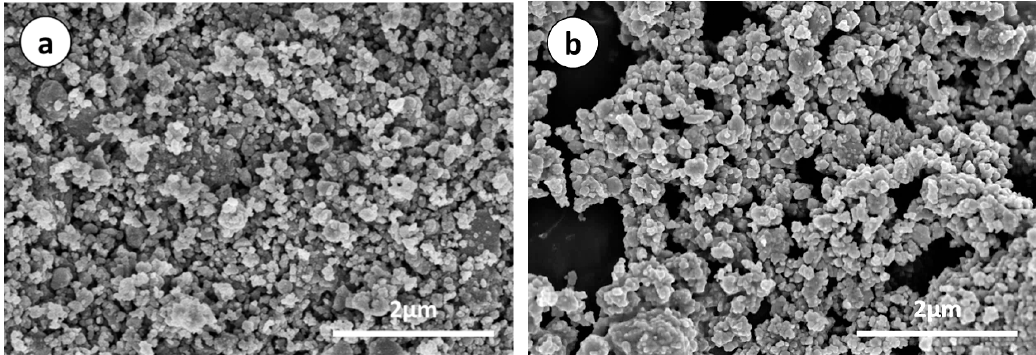
Figure 3. SEM images of ( a ) p -Si particles and ( b ) p -Si@C composites with carbon content of 45 wt.%.